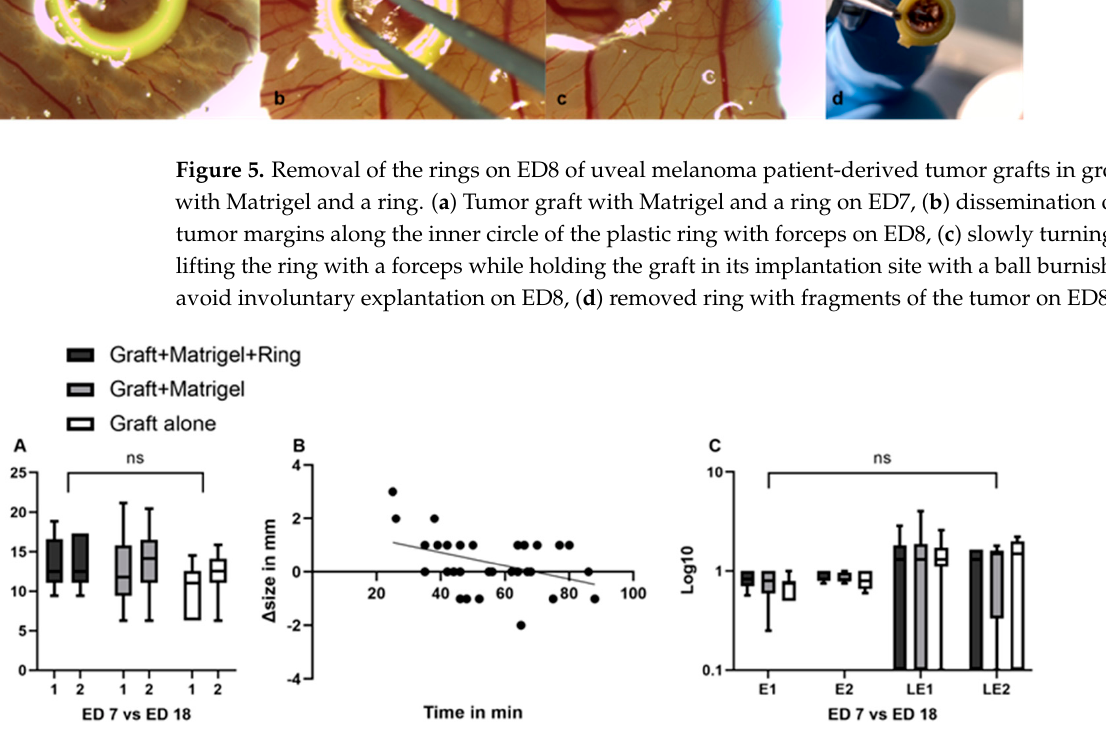
Figure 5. Removal of the rings on ED8 of uveal melanoma patient-derived tumor grafts in group 1 with Matrigel and a ring. ( a ) Tumor graft with Matrigel and a ring on ED7, ( b ) dissemination of the tumor margins along the inner circle of the plastic ring with forceps on ED8, ( c ) slowly turning and lifting the ring with a forceps while holding the graft in its implantation site with a ball burnisher to avoid involuntary explantation on ED8, ( d ) removed ring with fragments of the tumor on ED8.